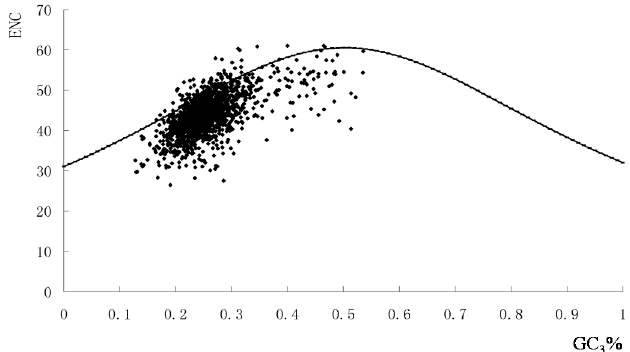
Figure 2. Graphs showing the relationship between effective number of codon (ENC) and the GC3% in functional genes of S. agalactiae genomes. The continuous curve indicated the expected codon usage if GC compositional constraints alone account for codon usage bias.